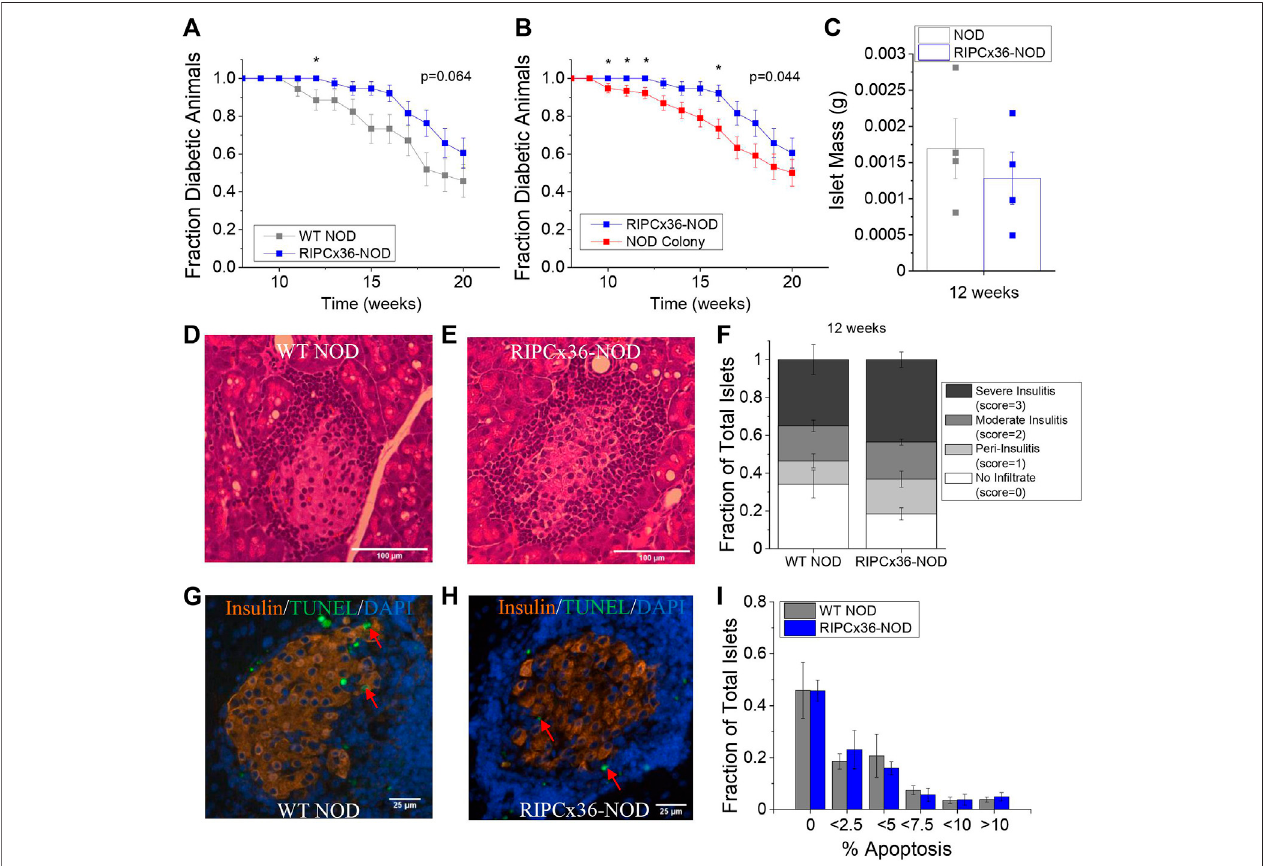
FIGURE 6 | Overexpression of Cx36 protects against T1D onset between 10 – 16 weeks of age in the NOD mouse. (A) Kaplan-Meier survival analysis of diabetes onsetinWTNOD(grey, n =34)andRIPCx36-NOD(blue, n =38)mice. p < 0.05indicatesasigni fi cantdifferenceinsurvivalprobabilityasdeterminedbytheBreslowtest. (B) Kaplan-Meier survival analysis of diabetes onset in NOD mice (NOD colony, red, n = 77) and RIPCx36-NOD (blue, n = 38) mice. p < 0.05 indicates a signi fi cant difference in survival probability as determined by the Breslow test. (C) Average islet mass per pancreas in 12-week old WT NOD (grey) and RIPCx36-NOD (blue) pancreata. Representative images of H&E staining in WT NOD (D) insulitis score = 2 and RIPCx36-NOD (E) insulitis score = 3 pancreas. (F) Fraction of total islets averaged over 6 slices per pancreas with an insulitis score of 0, 1, 2, or 3 in 12-week old WT NOD ( n = 5) and RIPCx36-NOD ( n = 6) mice as determined by IHC. RepresentativeimagesofTUNELandinsulinstaininginpancreassectionsfromWTNOD (G) andRIPCx36-NOD (H) mice.RedarrowsindicateTUNEL+insulin+cells. (I) Histogramoftheaveragefraction oftotalisletswithincreasingpercentage ofapoptotic (TUNEL + )insulin + cellsper isletinWTNOD(grey, n =4)andRIPCx36-NOD (blue, n = 4) islets. Data represents the mean ± SEM. All animals are female unless otherwise